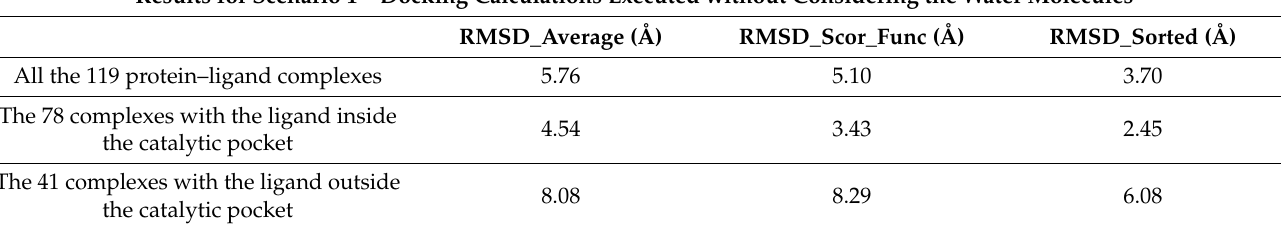
Table 1. Table representing the self-docking results obtained for Scenario 1.